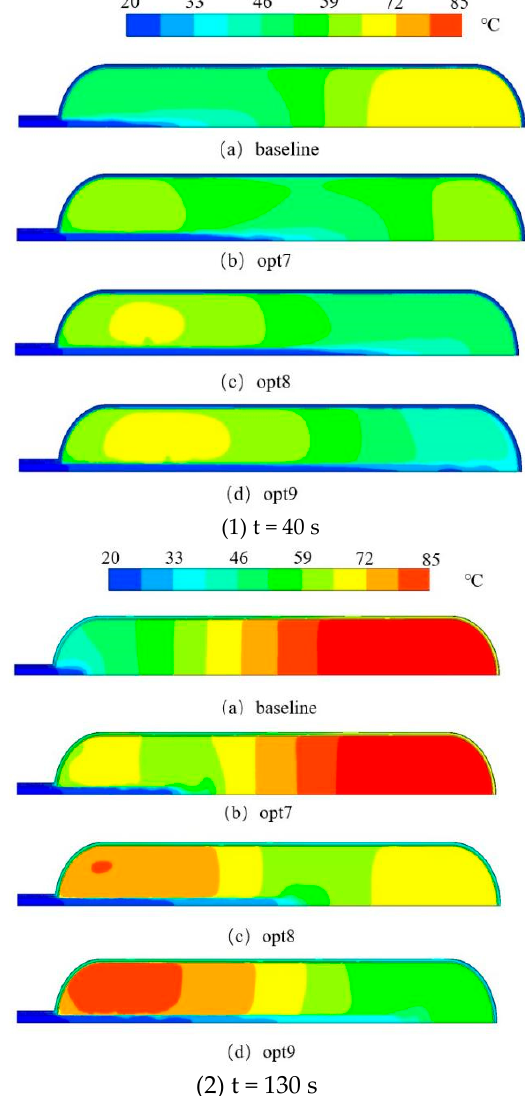
Figure 12. Temperature and velocity contour of hydrogen inside the cylinder at 40 s and 130 s.